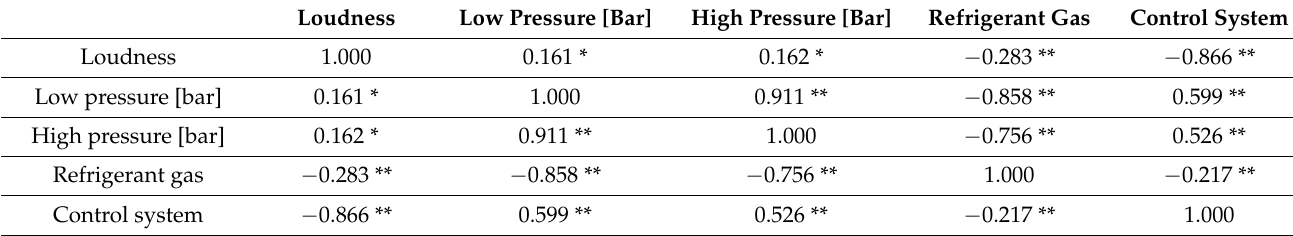
Table 3. Statistical results of Pearson’s